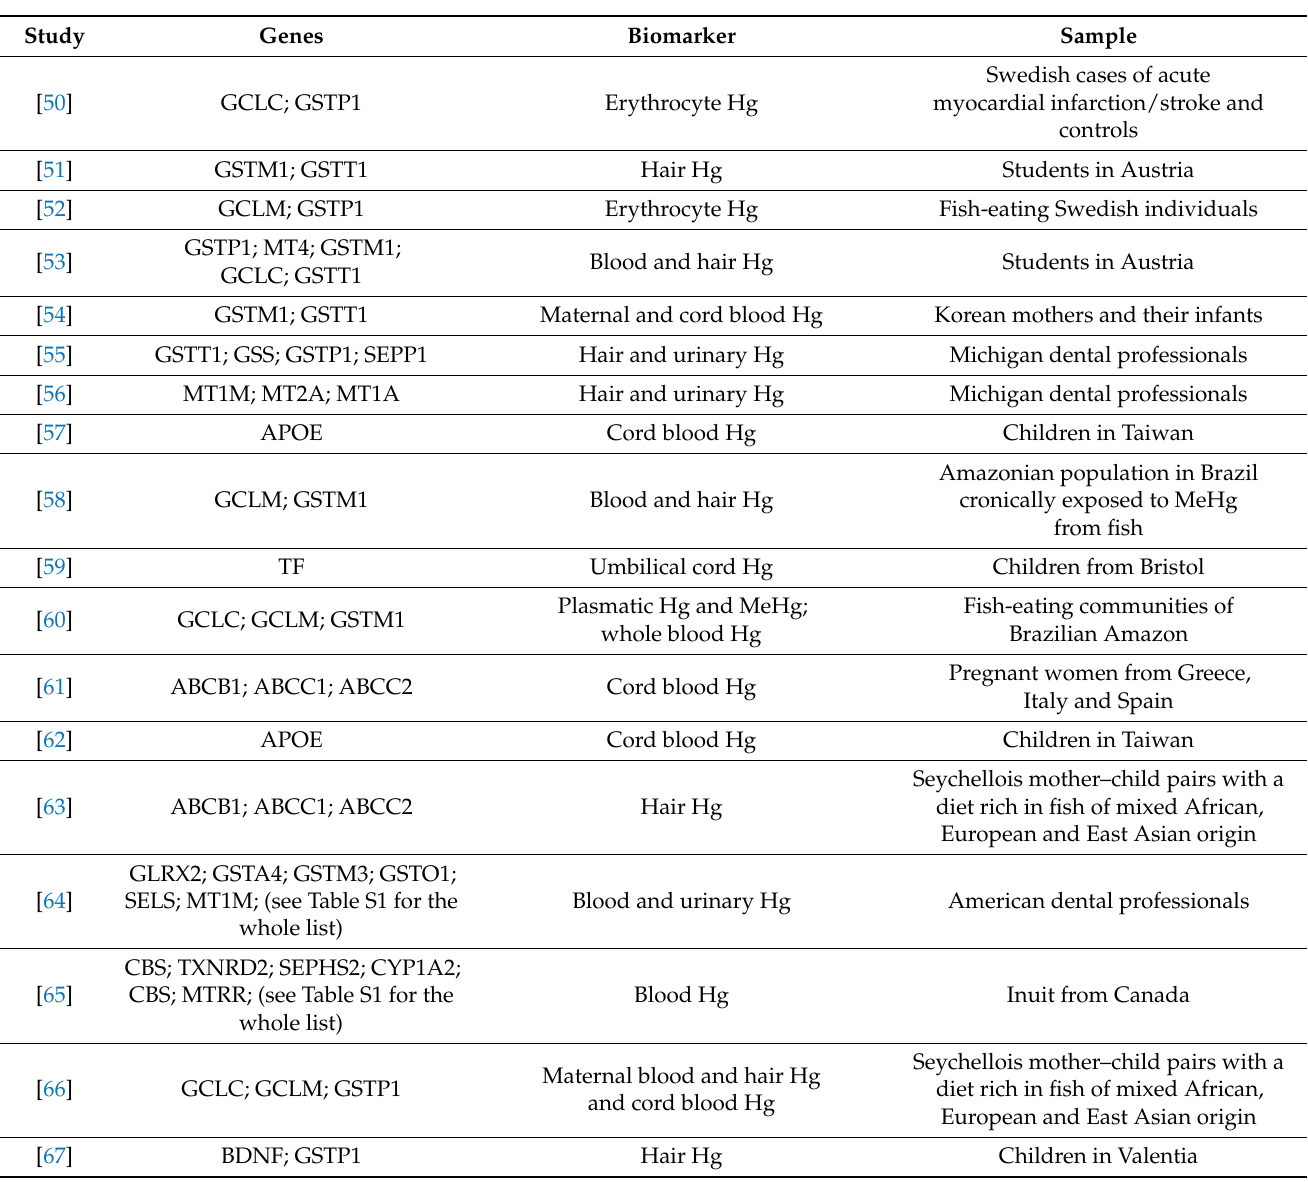
Table 1. List of epidemiological studies investigating the influence of genetic polymorphisms on MeHg toxicokinetic. Genes in which the above polymorphisms were identified, biomarkers affected, and samples studied are shown for each study.